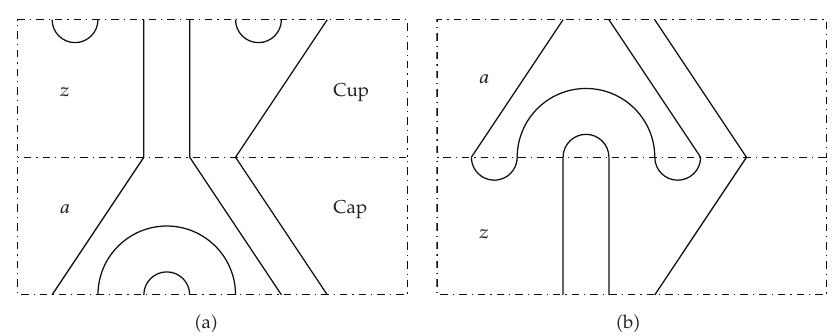
Figure 5: On the left side, a (cid:4) 7 , 7 (cid:5) diagram with k (cid:8) 3 through-strands and l (cid:8) 2 top arcs (cid:4) resp., bottom arcs (cid:5) is decomposed into a (cid:4) 7 , 3 (cid:5) cap diagram a -composed with a (cid:4) 3 , 7 (cid:5) cup diagram z . On the right side, an element of TL 3 is obtained by composing a and z in the opposite